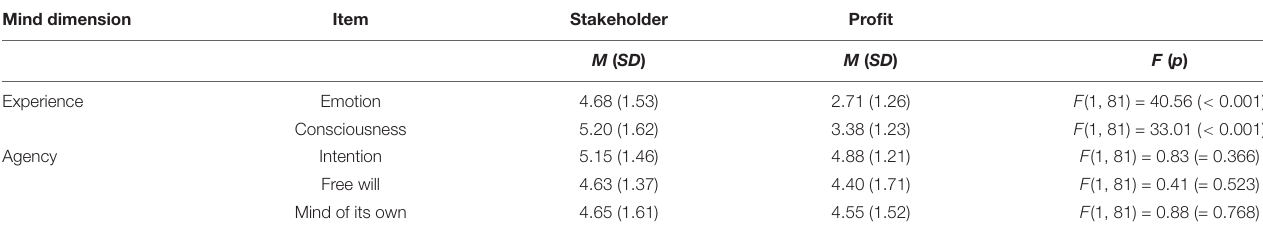
TABLE 2 | Means, standard deviations, and significance levels of experience and agency items in experiment 1. Mind dimension Item Stakeholder